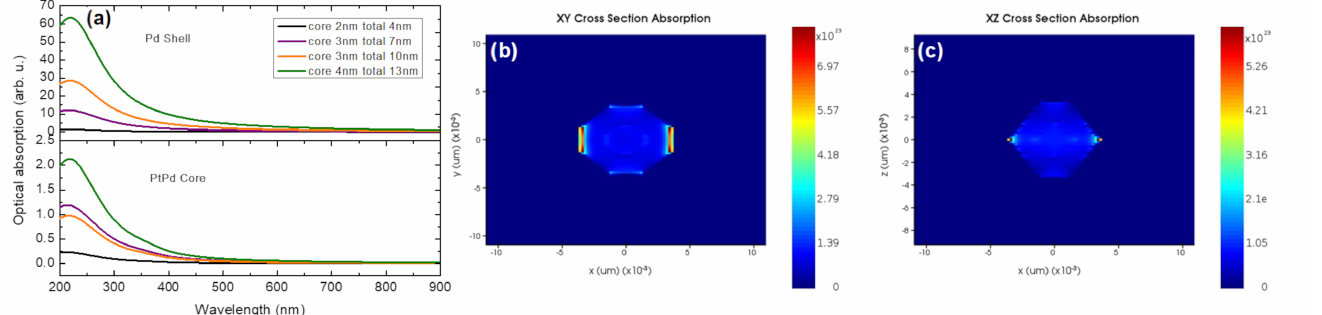
Figure 8. ( a ) Optical absorption in PtPd core Pd shell truncated octahedron nanoparticles as obtained by FDTD simulations. ( b ) Cross sections at wavelength 238 nm in xy plane for the truncated octahedron with core 3 nm and outer shell 7 nm. ( c ) Cross sections at wavelength 238 nm in xz plane for the truncated octahedron with core 3 nm and outer shell 7